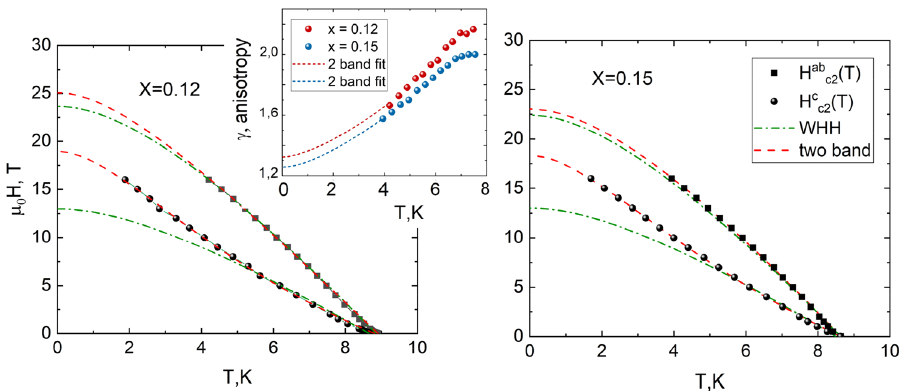
show approximation of experimental data by the two-band model. Inset: The anisotropy of the upper critical field γ = H γ(0) was calculated from the two-band model